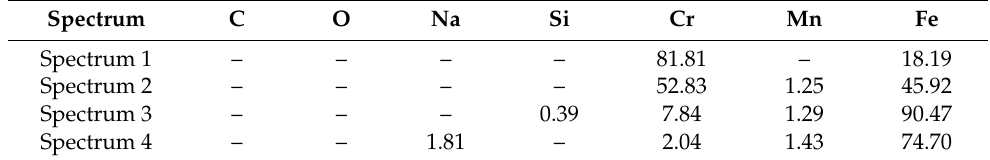
Figure 4. Energy spectrum of each point of chromium carbide coating. Table 2. Element content at each scanning point of the specimen with chromium carbide coating (wt.%).